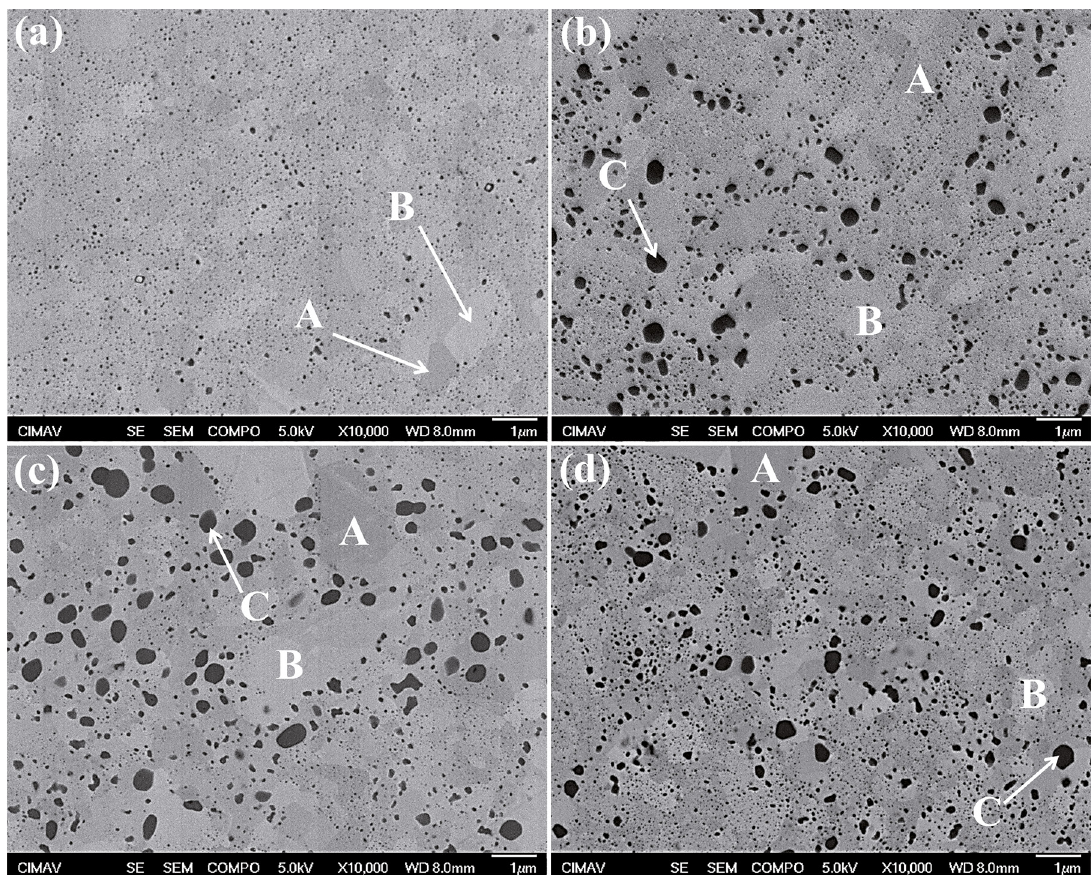
Figure 6: Backscattered electron SEM micrographs of the sintered samples AlCoNi: (a) 0, (b) 2.5, (c) 5.0 and (d) 10 wt.% SiC.